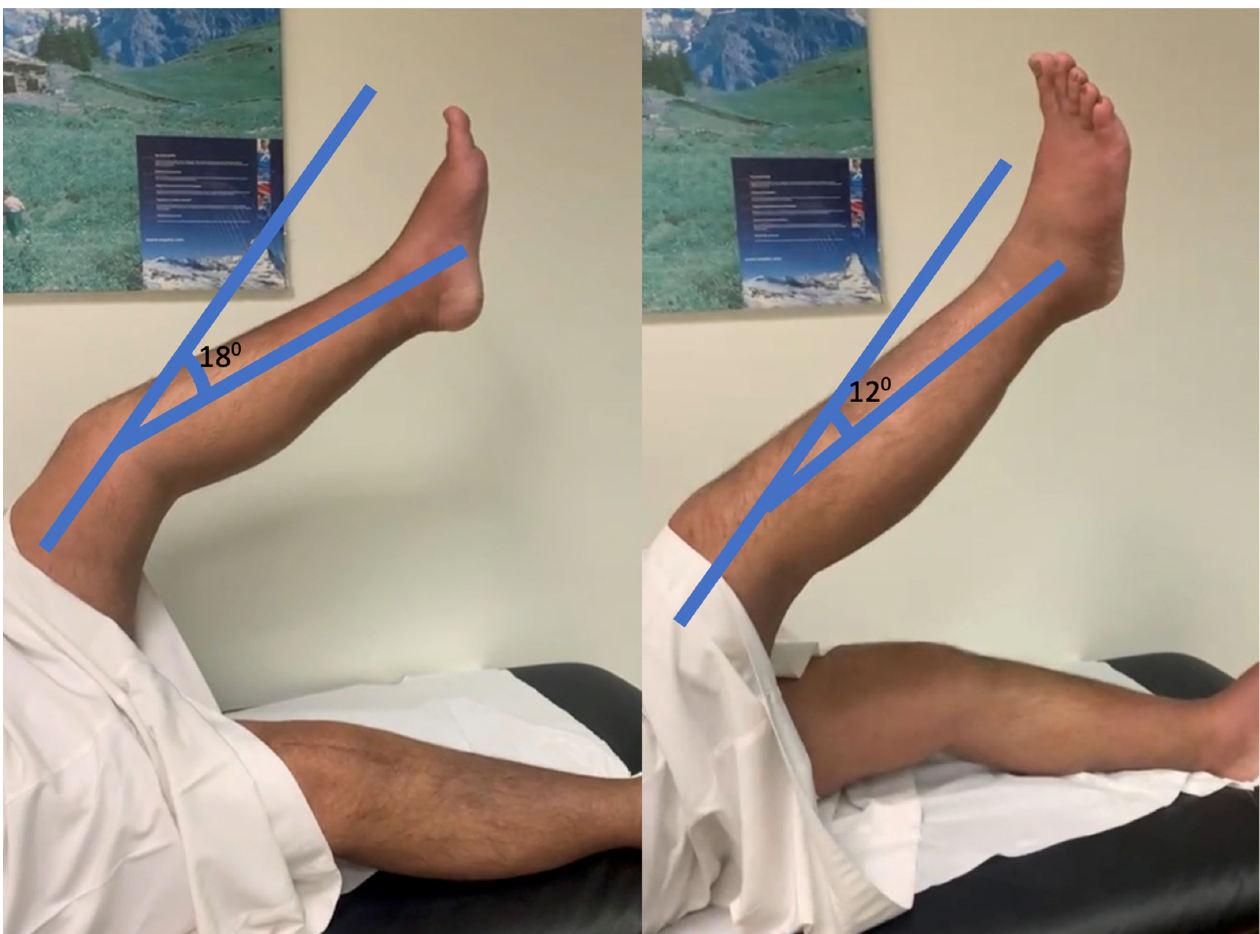
Figure 8. Showing the active hip knee extension in the left and right lower extremity .